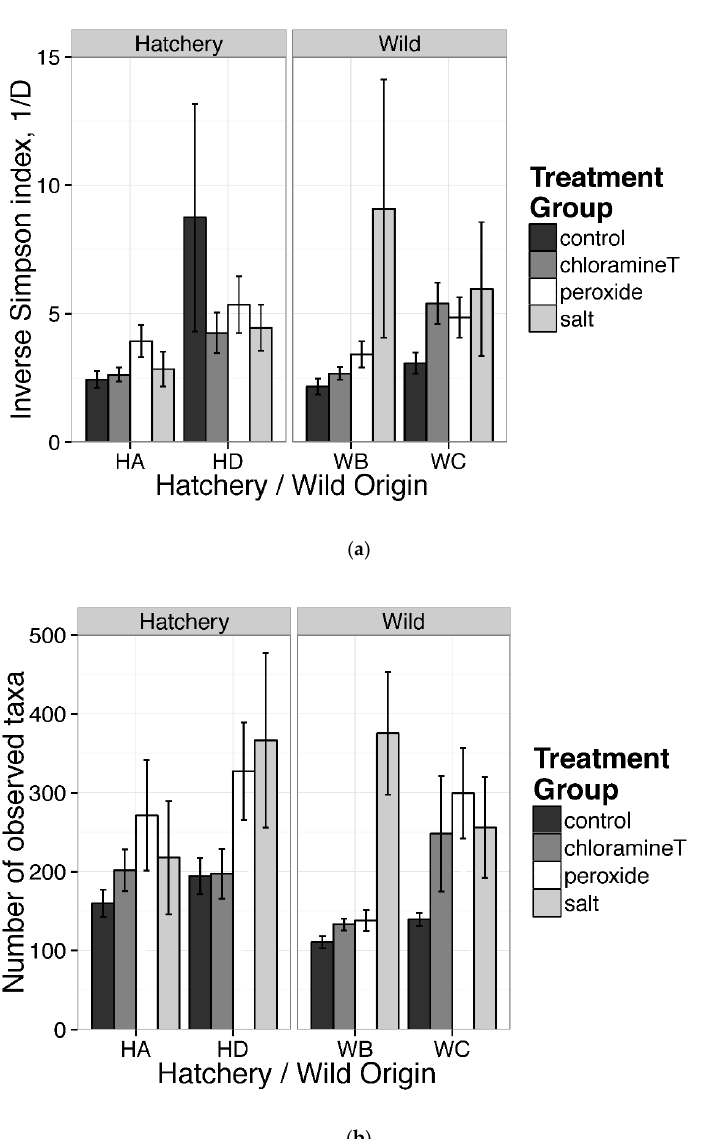
Figure 3. Estimates of alpha diversity: ( a ) inverse Simpson index; ( b ) number of observed taxa (OTU richness) for lake sturgeon gut microbial communities from all samples of treatments and families within location of origins. Each bar indicates mean with S.E. for each treatment from each family within